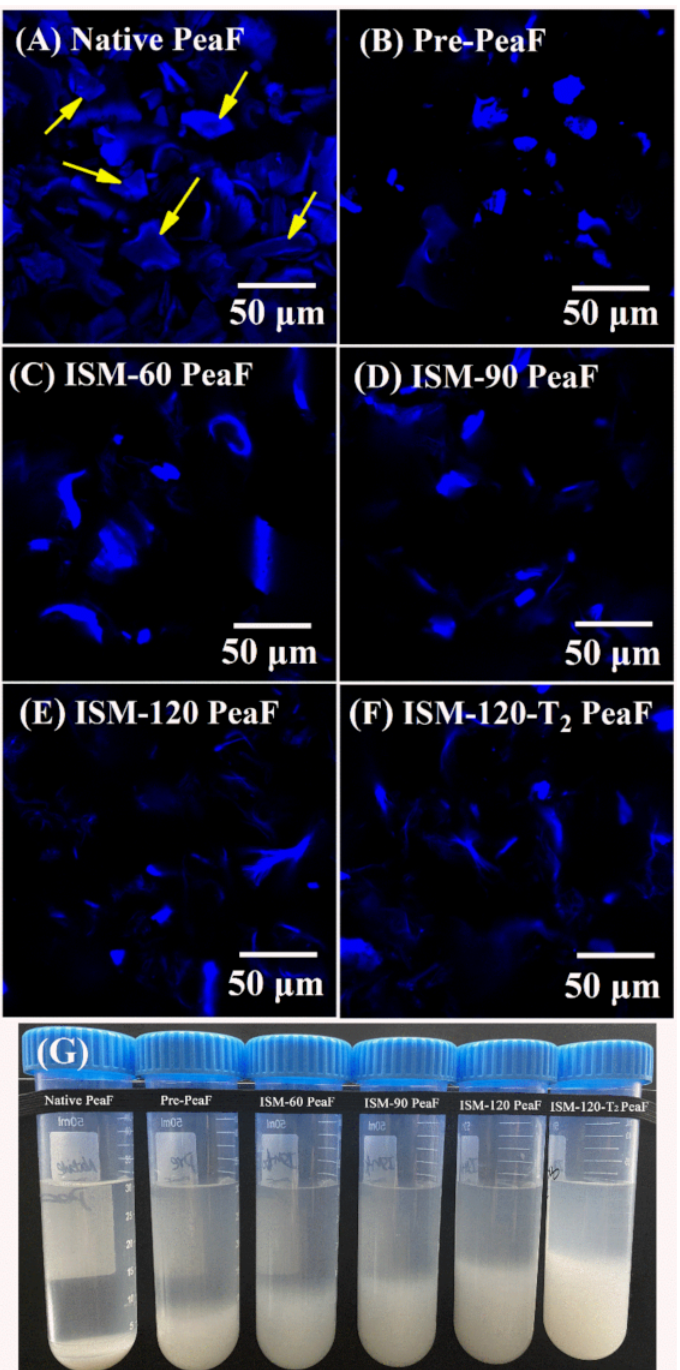
Figure 2. CLSM images and appearance of native PeaF and ISMS-treated PeaF. ( A ) Native PeaF; ( B ) Pre-PeaF; ( C ) ISM-60 PeaF; ( D ) ISM-90 PeaF; ( E ) ISM-120 PeaF; ( F ) ISM-120-T 2 PeaF; ( G ) Appear- ance of native peaF and ISMS-treated